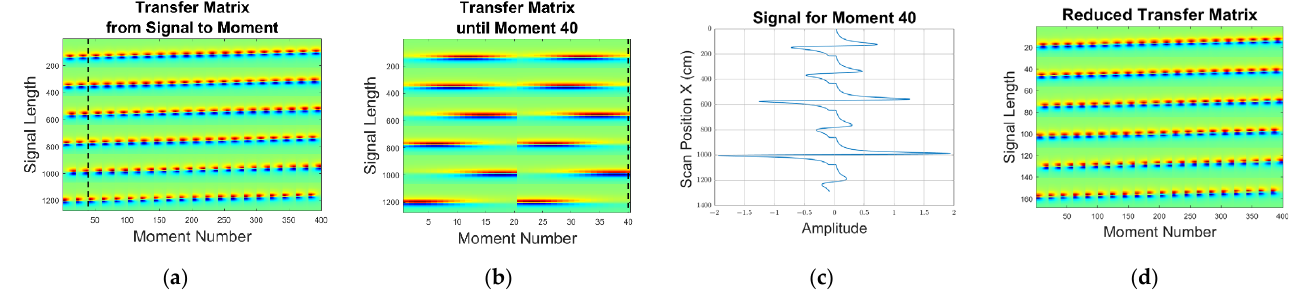
Figure 6. The transfer matrix from magnetic dipole moments to received signals. In vertical rows, showing the overall received signal from 6 receivers, each individual receiver signal extends over 200 samples. The 20 × 20 sheet hosts 400 independent moments (horizontal axis). Positive signal deflections are indicated in red, negative deflections in blue, and green indicates no deflection or zero: ( a ) The total transfer matrix from normalized moments to received signals, a signal collection for each position. The black line indicates the 40th moment; ( b ) Magnified transfer matrix until the 40th moment; ( c ) The signal sequence from 6 receivers for the 40th moment (dashed line in ( a ) and ( b ); all other moments are zero for this entry); ( d ) Due to sampling theorems, the transfer matrix can be condensed to less than 200 signal entries without losses.